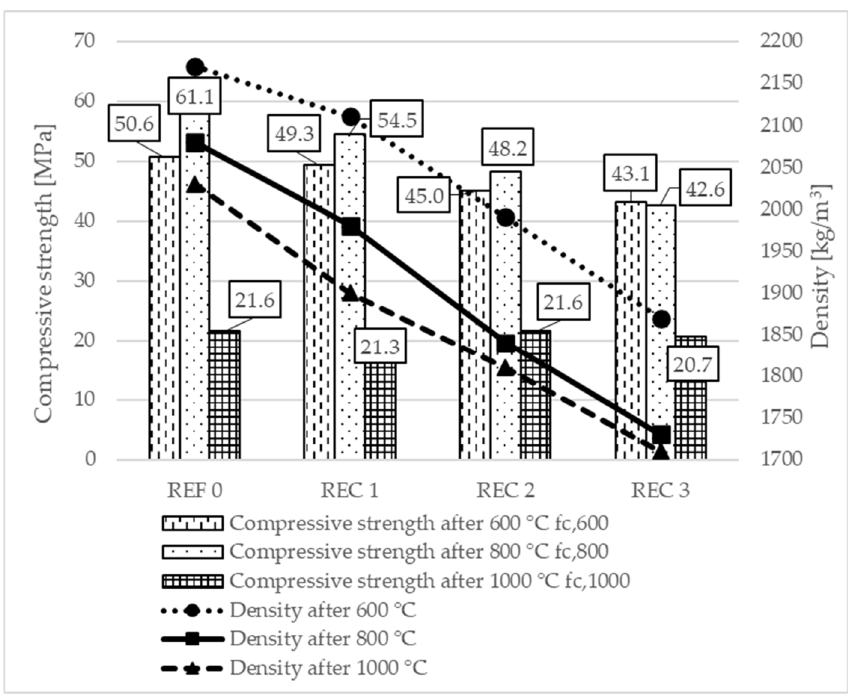
Figure 8. Overview of mechanical properties of lightweight concrete after high temperature load- ing.